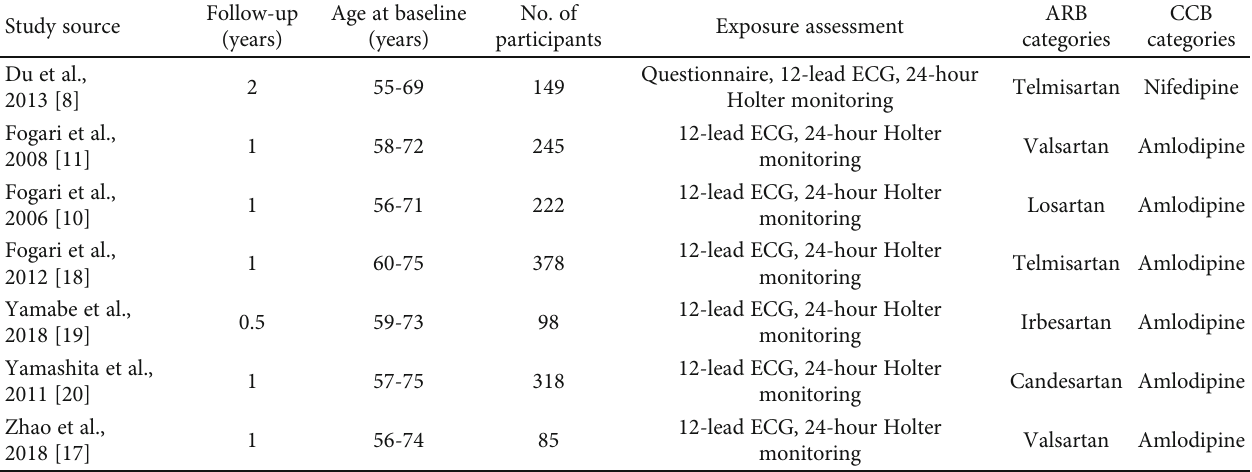
Figure 2: Flow charts showing relevant studies. Table 1: Characteristics of studies included in the